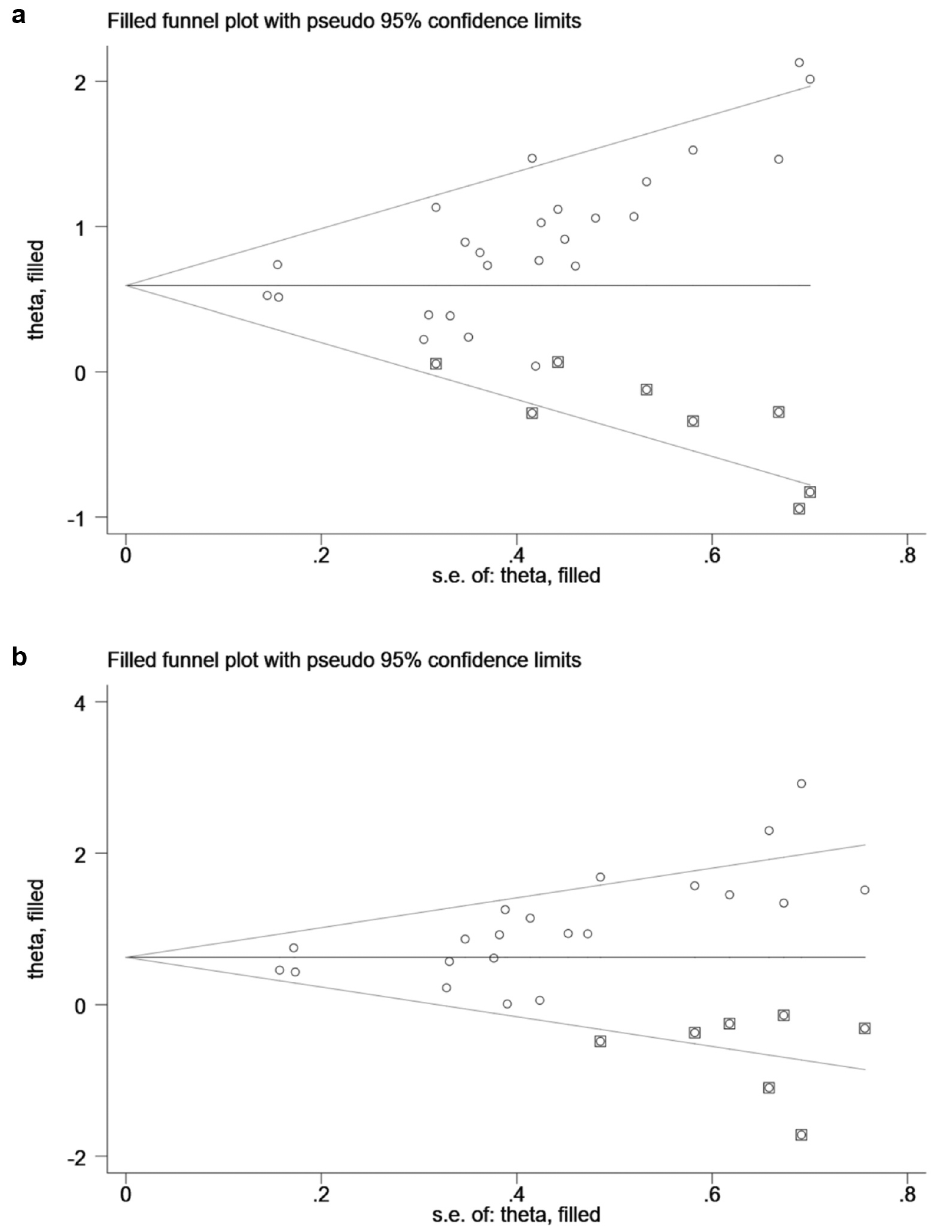
Fig 3. Begg’s funnel plot with trim-and-fill analysis for publication bias. (a) event-free survival (EFS) and (b) overall survival (OS). The circles in squares indicated the hypothesized studies, which were also incorporated to generate symmetrical funnel